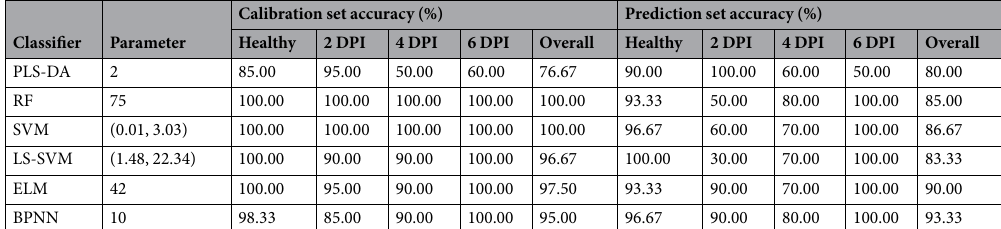
Table 2. Overall and individual class classification accuracies of machine-learning models with texture features. a a Parameters and abbreviations as in Table 1.